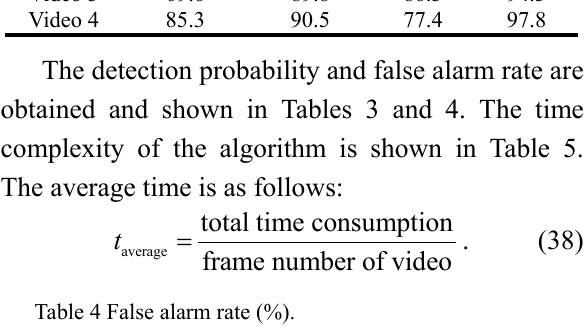
Fig. 1 Background suppression result: (a) the original image, (b) the result after adaptive TCAIE-LGM smoothing, (c) GLCM of the original image, and (d) GLCM of the smooth image.